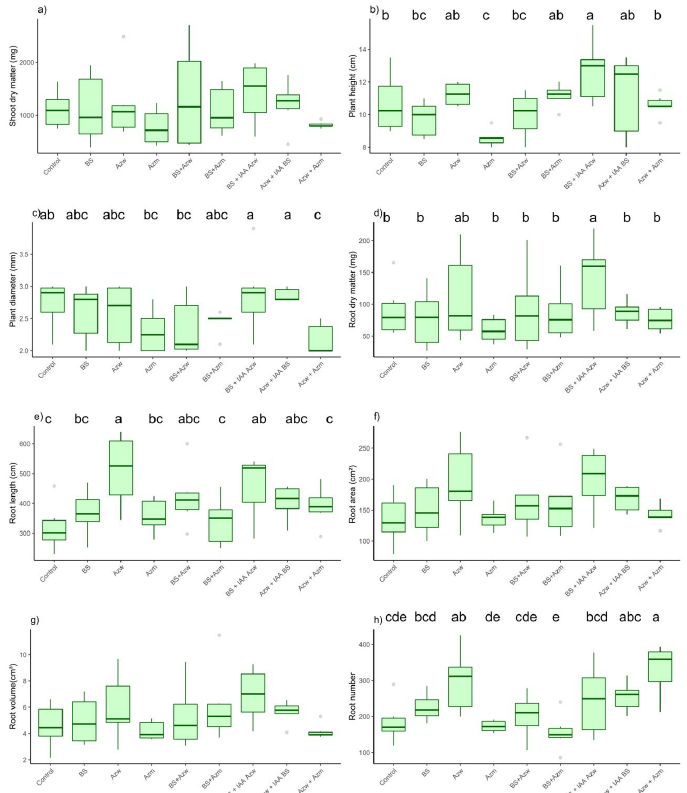
Figure 7. Boxplots for growth evaluation of dgt tomato plants inoculated with auxin-synthesizing bacteria. ( a ) shoot dry mass, ( b ) plant height, ( c ) plant diameter, ( d ) root dry matter, ( e ) root length, ( f ) root area, ( g ) root volume, ( h ) number of roots. Means followed by the same lowercase letter or absence of letters do not differ by Tukey’s test ( p < 0.05). Control, without inoculation; BS, B. subtilis; Azw, A. brasilense wild; Azm, A. brasilense mutant; BS + Azw, B. subtilis + A. brasilense wild; BS + Azm, B. subtilis + A. brasilense mutant; BS + IAA Azw, B. subtilis + exogenous auxin (400 µ g mL − 1 ); Azw + IAA BS, A. brasilense + exogenous auxin (30 µ g mL − 1 ); Azw + Azm, A. brasilense wild + A. brasilense